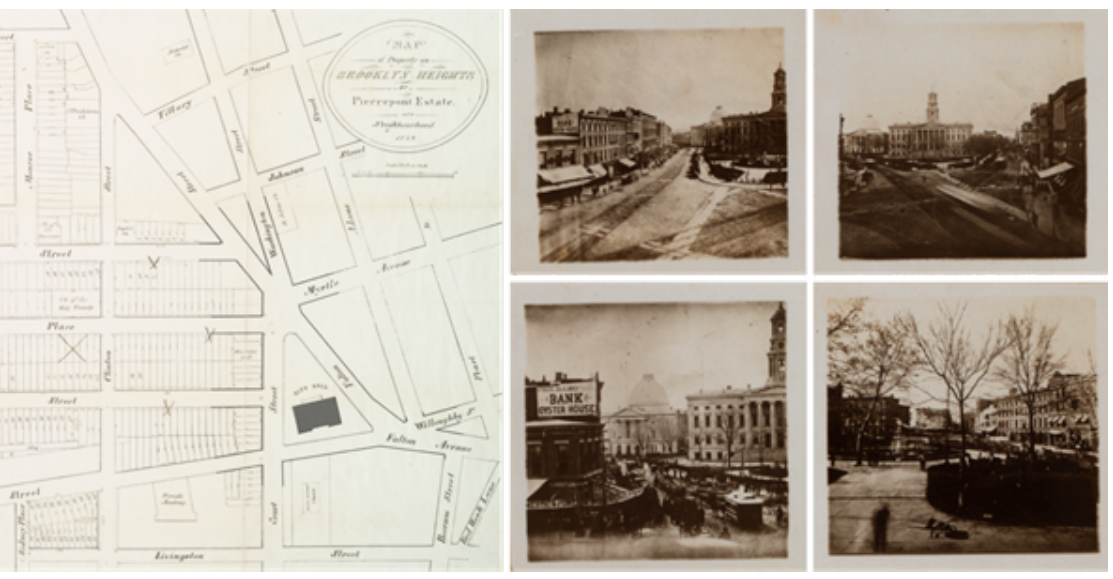
Figure 7. Left: 1849 survey of City Hall and adjacent blocks with author’s highlights; right: views of City Hall and County Courthouse, ca. 1876, with park and urban fabric around the space (Source: New York Public